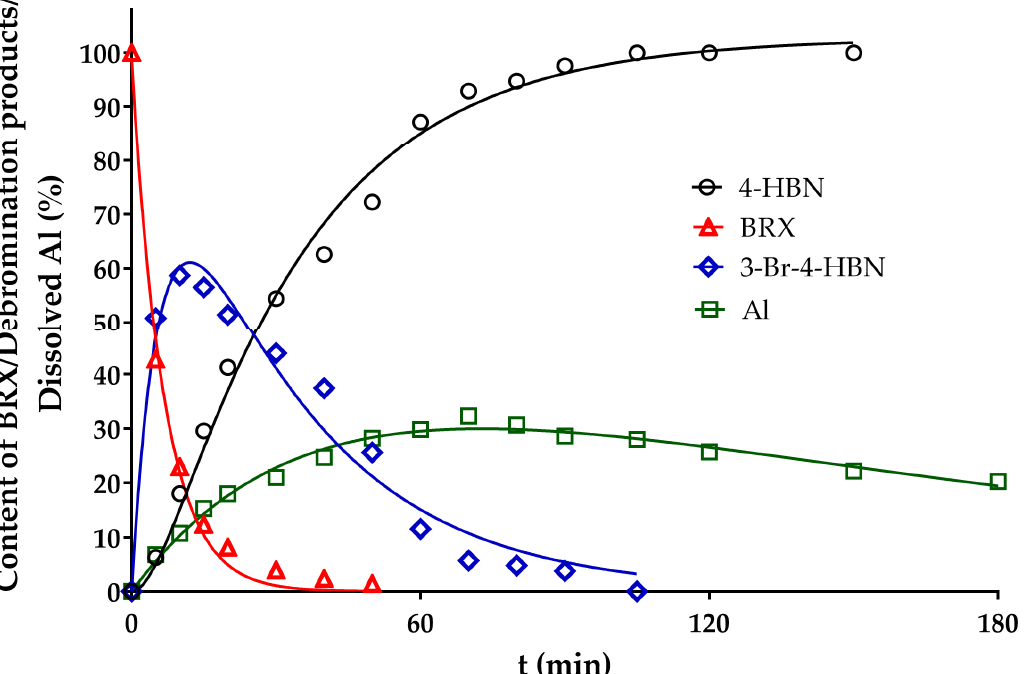
Figure 1. Kinetics of the HDB of BRX (5 mM) in 100 mM aq. NaOH using Dev. alloy (3 g/L). In addition, the percentage of soluble part of Al from original Dev. alloy is supplemented.